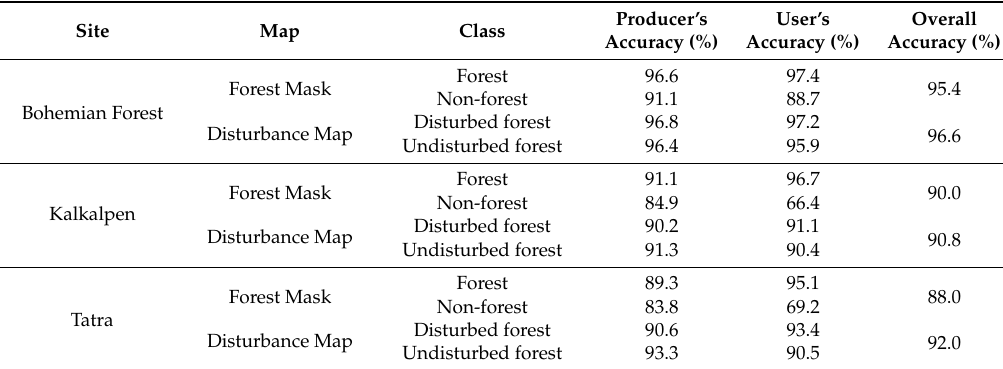
Table 4. Overview of out-of-bag (OOB) model accuracies of forest masks and disturbance maps created for the study